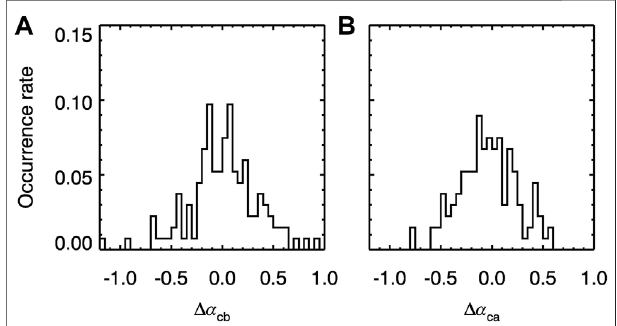
FIGURE 5 | (A) Histograms of the difference of the spectral index value between the time interval containing the MH and the time interval before the one containing the MH; (B) histograms of the difference of the spectral index value between the time interval containing the MH and the time interval after the one containing the